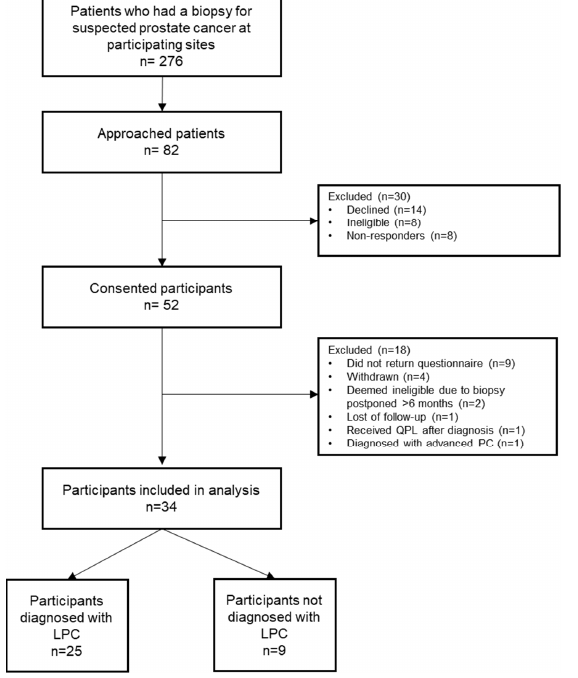
Figure 2. CONSORT diagram. QPL, question prompt list; LPC, localised prostate cancer.